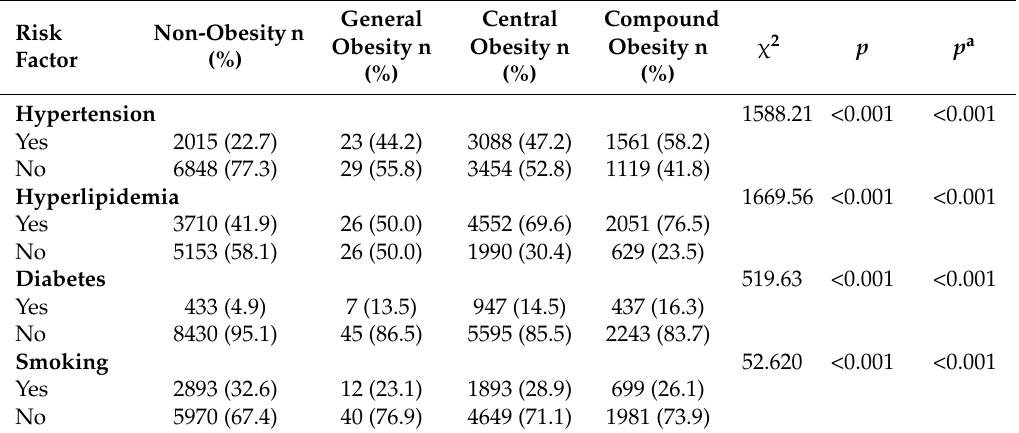
Table 3. Rate of CVD risk factors in different types of obesity.